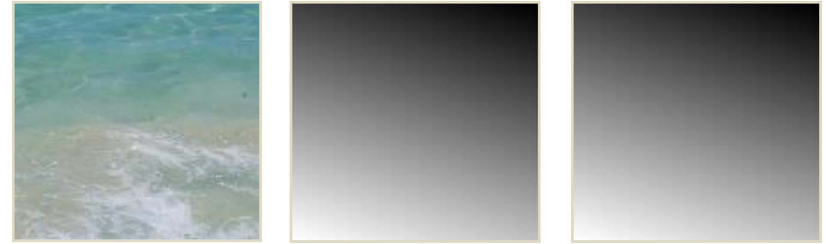
Figure 4. We obtain scale maps for the given tilt and slant. From the left to the right: the input example, scale map with s =30 u and t =18 u , scale map with s =60 u and t =60 u .